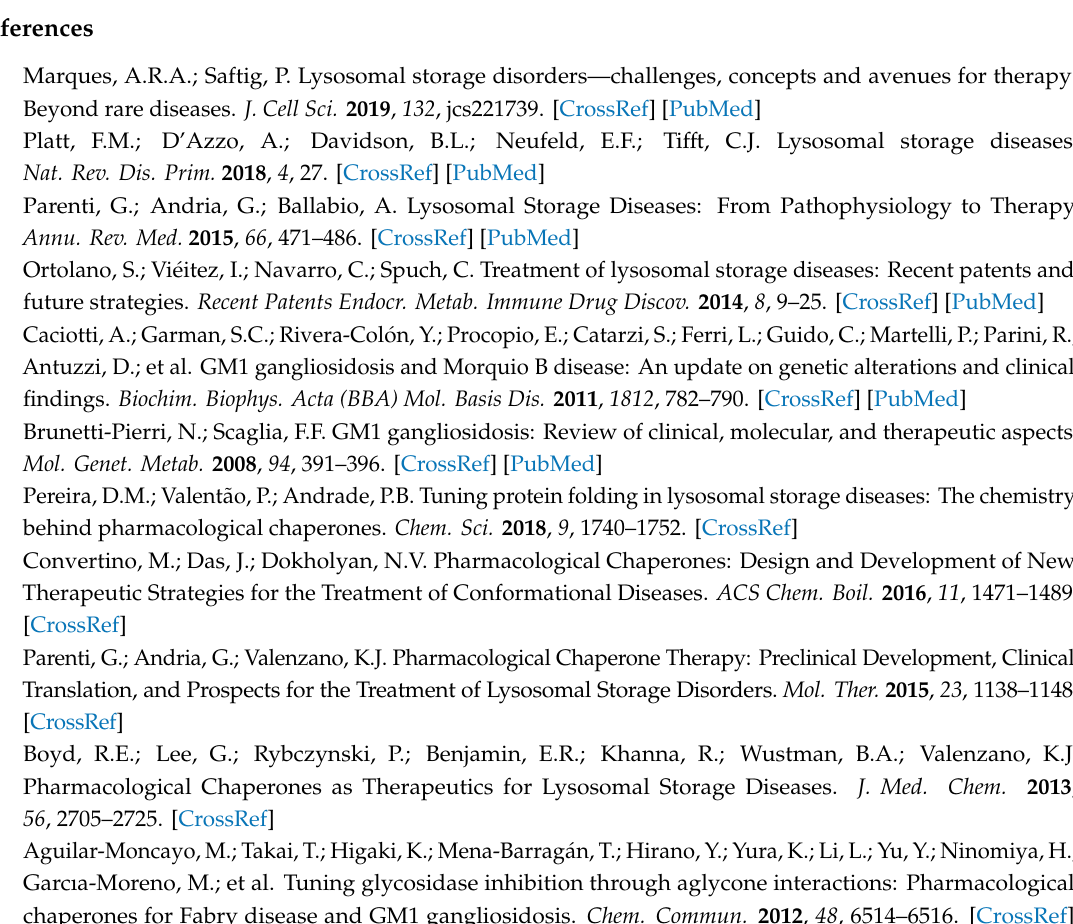
Supplementary Materials: Figures S1–S44 containing 1 H and 13 C-NMR of new compounds, Table S1: Addition of sp 3 Grignard reagents to ketone 8 . Table S2: Configuration assignment. Table S3: Biological screening towards commercial glycosidases. Figure S45: IC 50 for compound 10 towards β -glucosidase from almonds. Figure S46 and Figure S47: Biological screening towards human lysosomal β -Gal and GCase. Figures S48–S51: IC 50 for compounds 9 , 10 , 12 , and 21 towards GCase. Figure S52 to Figure S54: Chaperoning activity assay of compounds 9 , 10 , and 12